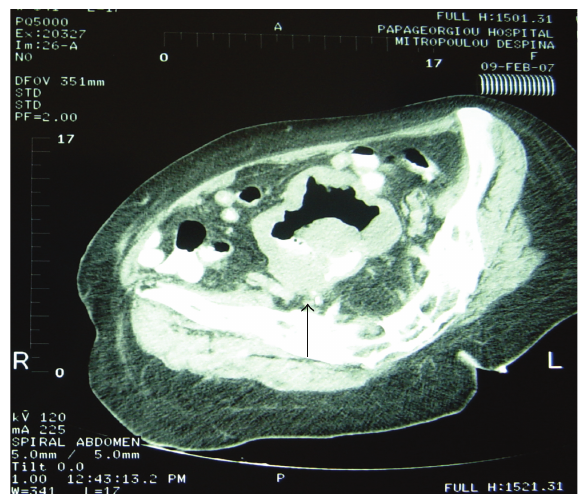
Figure 1: Preoperative CT examination of the patient.